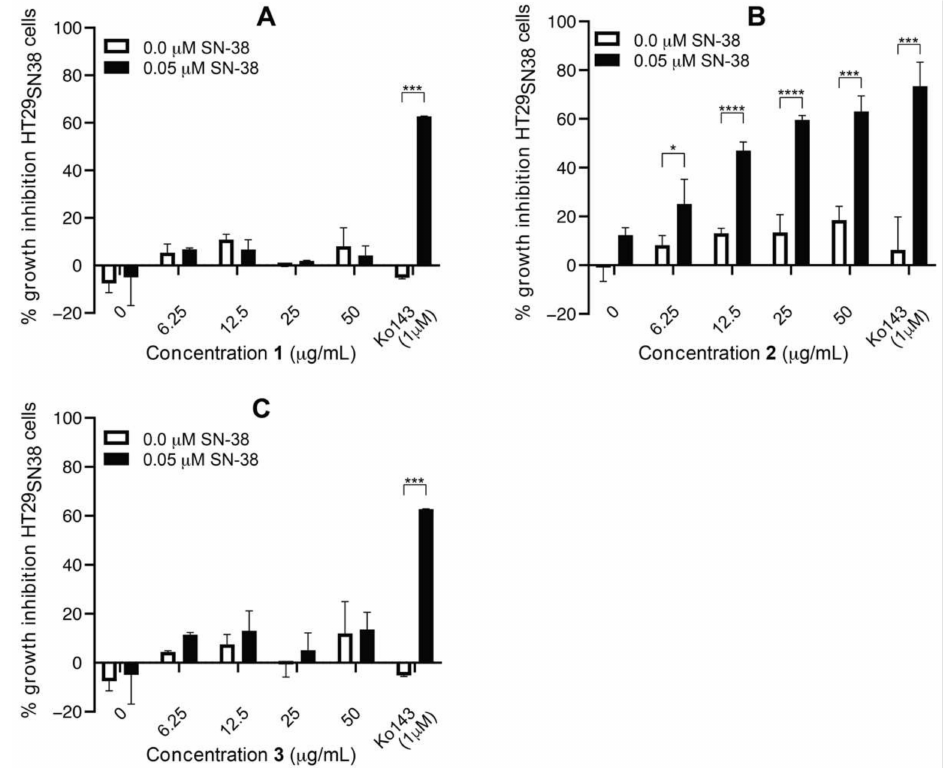
Figure 6. Percent cell-growth inhibition of HT29 SN38 cells treated with 6.25, 12.5, 25, and 50 µ g/mL of compounds 1 ( A ), 2 ( B ), and 3 ( C ) alone and in combination with 0.05 µ M SN-38. Ko143 (1 µ M) was used as a positive control. Error bars indicate SD determined on the basis of n = 2. * p ≤ 0.05, *** p ≤ 0.001, **** p ≤